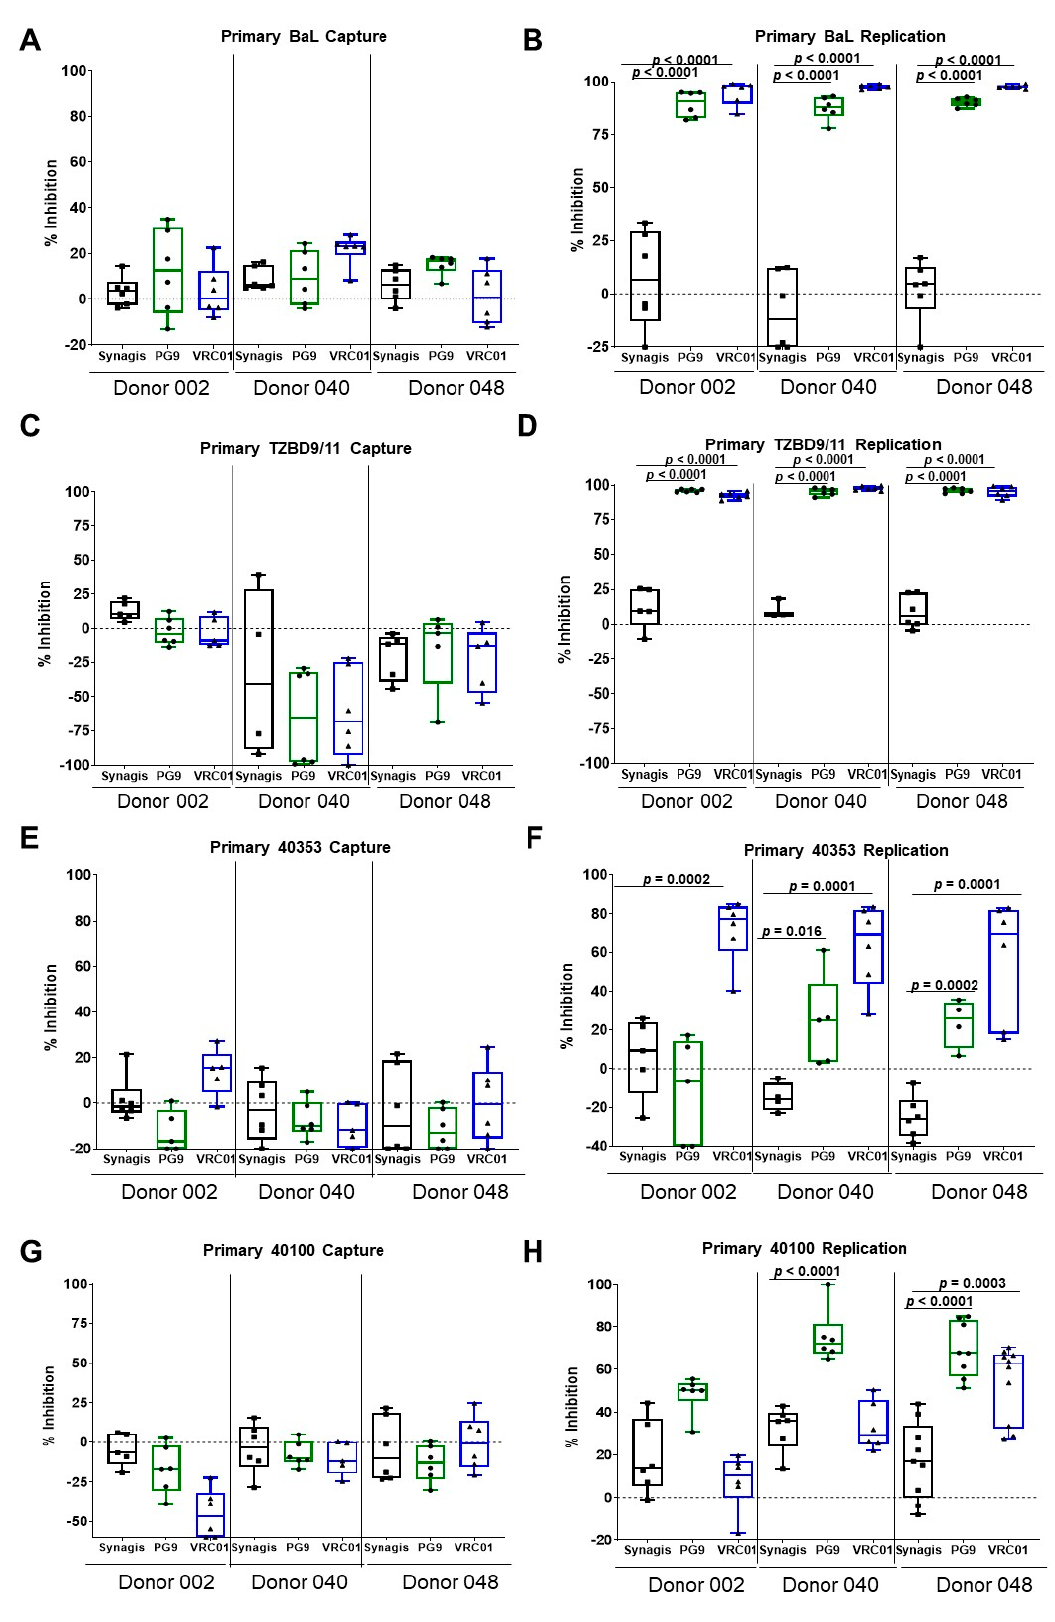
Figure 2. bNAbs do not inhibit virus capture of primary HIV-1 BaL, TZBD9 / 11, acute 40353, and acute 40100 but do inhibit virus replication in PBMCs. ( A ) PG9 and VRC01 did not inhibit the capture of primary subtype B, BaL, to the three donor PBMCs examined. ( B ) The bNAbs inhibited the